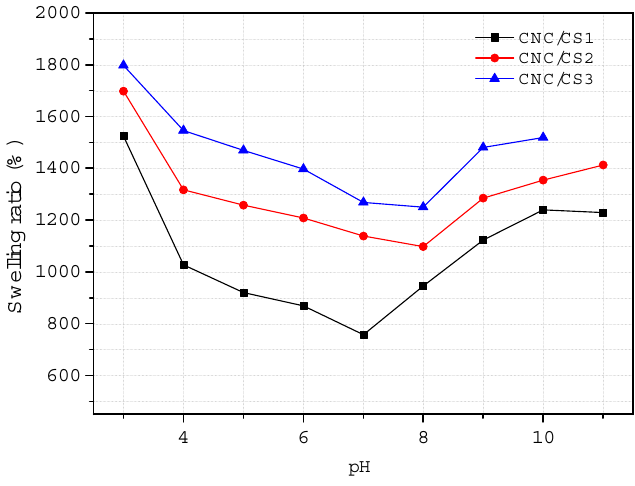
Figure 4. Swelling ratio of CNC/CS composite hydrogel at varied pH.